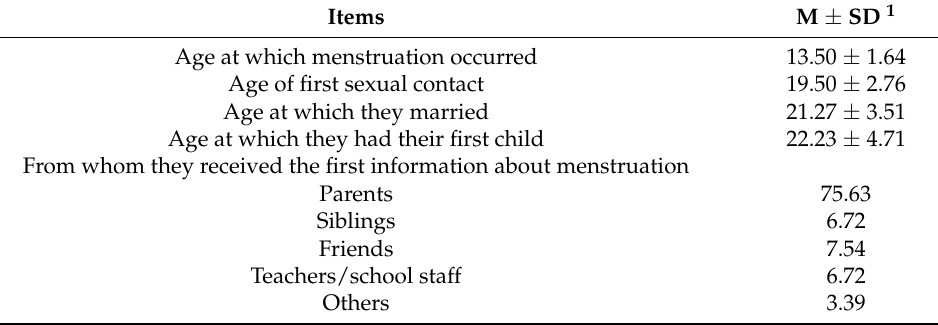
Table 2. Sexual-related information data.